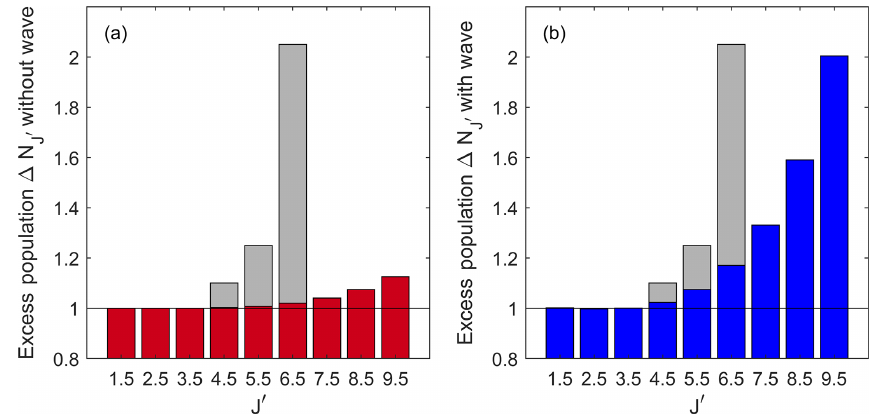
Figure 5. The calculated apparent excess population of the OH (7,4) P(J (cid:48) ) lines relative to the Boltzmann population of the fitted temperature to the lowest three lines. Red in (a) is calculated with the climatological temperature gradient shown from NRLMSISE-00 above Boulder, Colorado (40.0 ◦ N; 105.6 ◦ W), in mid-July. Blue in (b) is calculated with a wave of A w = 30K at 90km, λ w = 30km and a phase that yields the maximum effect, ϕ w = 4 . 9 rad. This is the same wave as presented in Figs. 3 and 4. The distribution has a β = 0 . 019. The grey bars represent the measurements ascribed to NLTE effects from Pendleton et al. (1993).